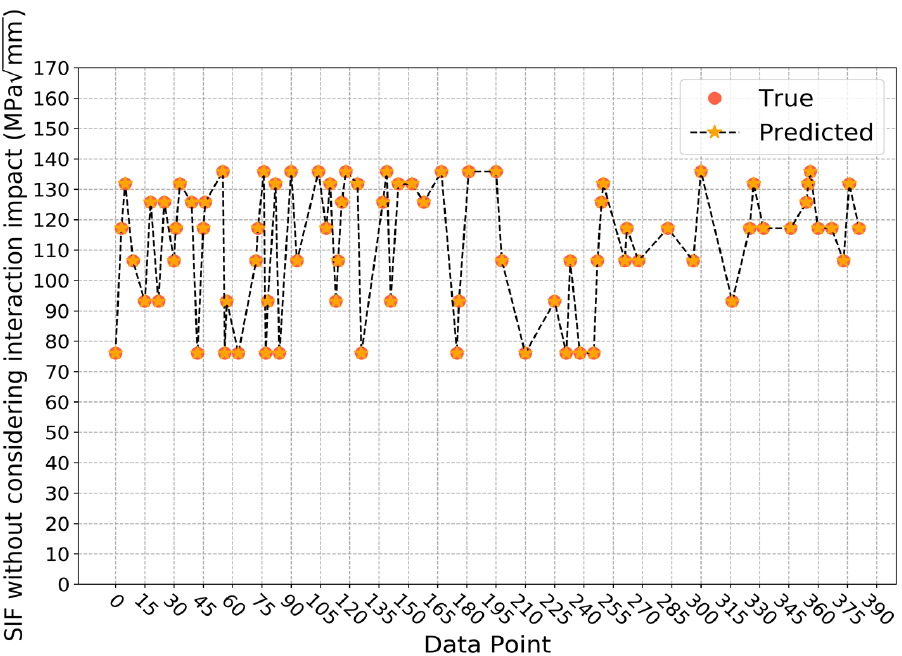
Figure 9. Prediction results of SIF values without considering interaction impact based on approach 2.